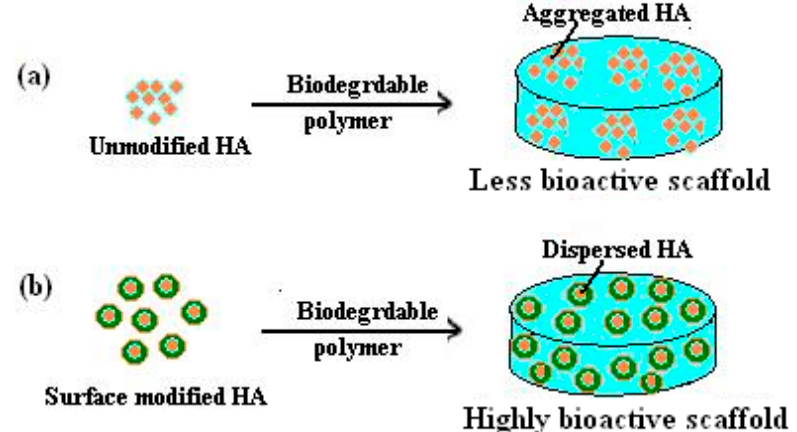
Figure 25. Schematic diagram depicting the effect of surface modification of nHA by biomolecules on the bioactivity of scaffolds. ( a ) scaffold with nHA; ( b ) scaffold with modified nHA.